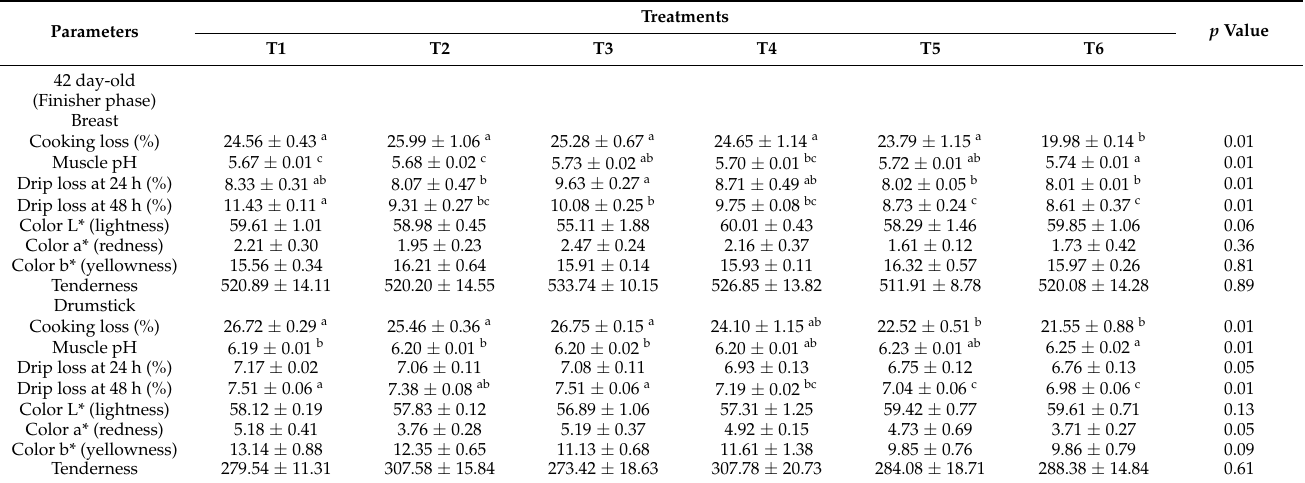
Table 9. Effect of Y. schidigera supplementation on the meat quality of broilers on day